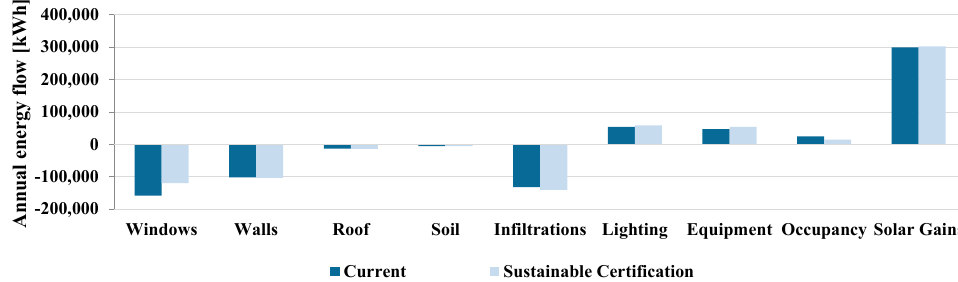
Figure 14. Estimated annual energy flows for the current building and the building subjected to the guidelines for sustainable building.